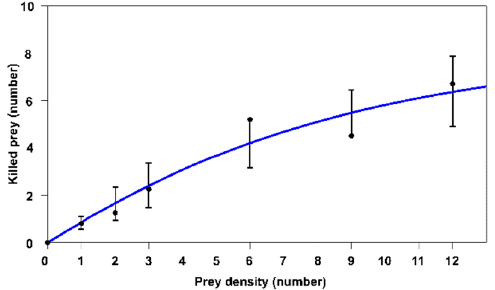
Figure 2. Type II functional response (number of pest eggs killed) of the adult female of Blattisocius tarsalis when different egg densities of Phthorimaea operculella were offered as prey for 24-hours under laboratory conditions (whisker plot: 95% confidence intervals). Table 1. Logistic regression analyses results for the proportion of Phthorimaeae operculella eggs killed by the adult female of Blattisocius tarsalis in the bioassay carried out under laboratory conditions.